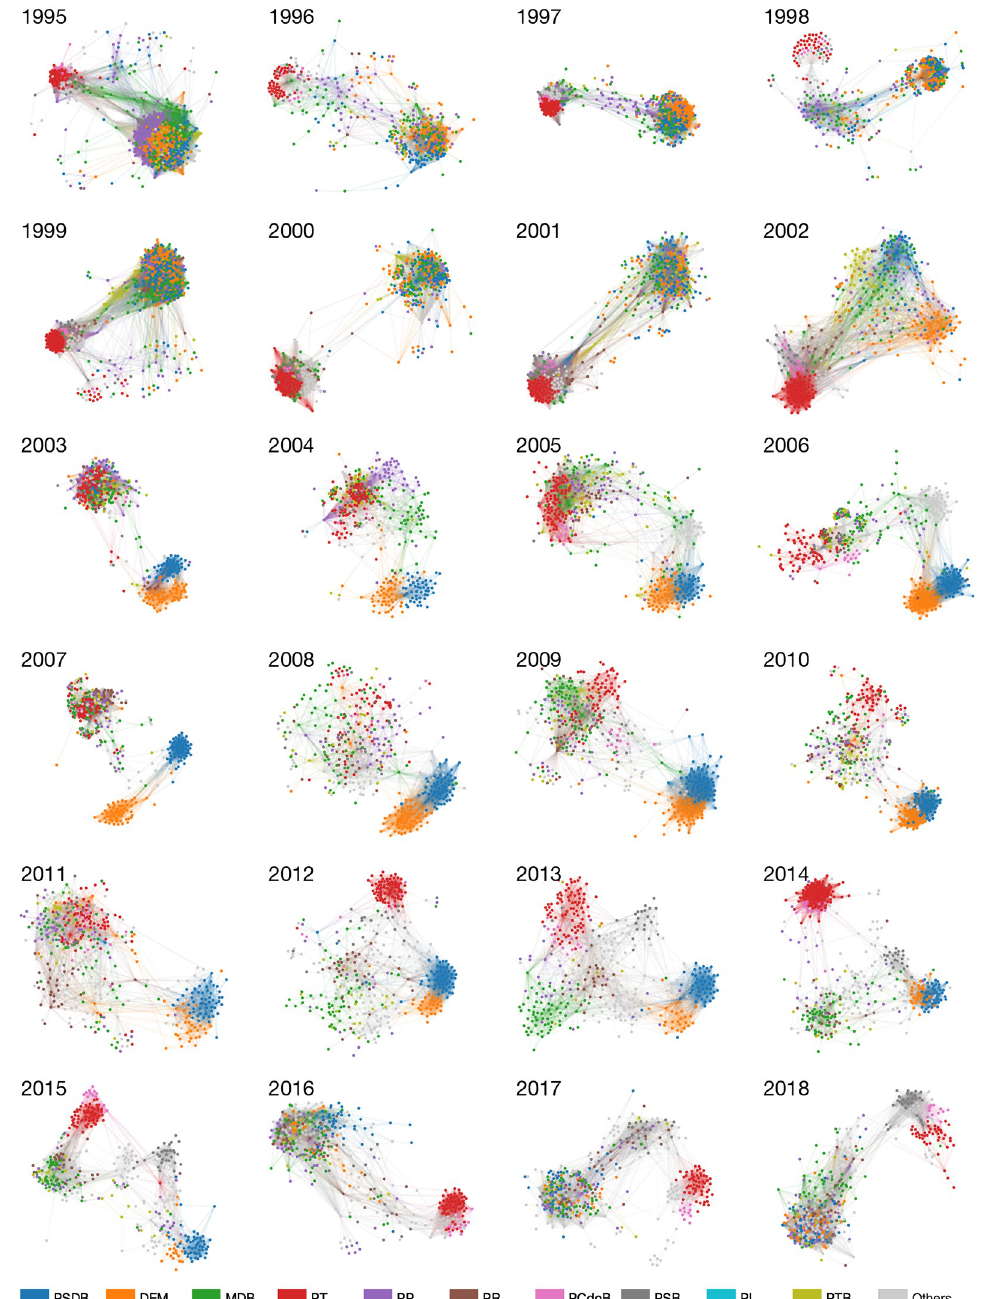
Fig 5. Visualization of the time evolving network obtained from voting data. Each yearly snapshot was obtained considering only the proposals voted in that year. Colors correspond to parties.